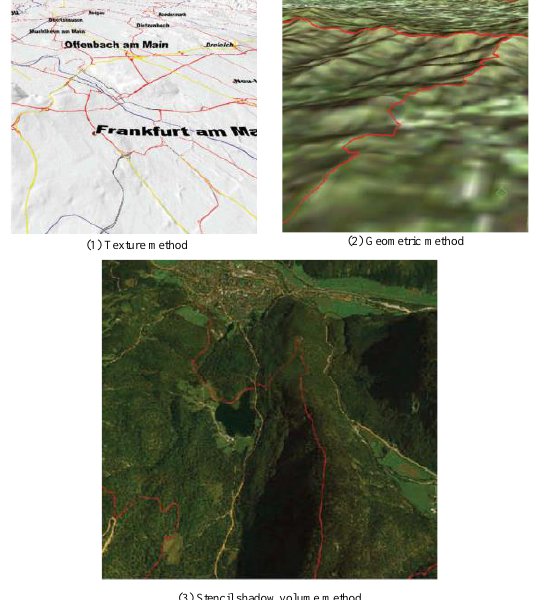
Figure 4. Examples of 3D rendering using different techniques.